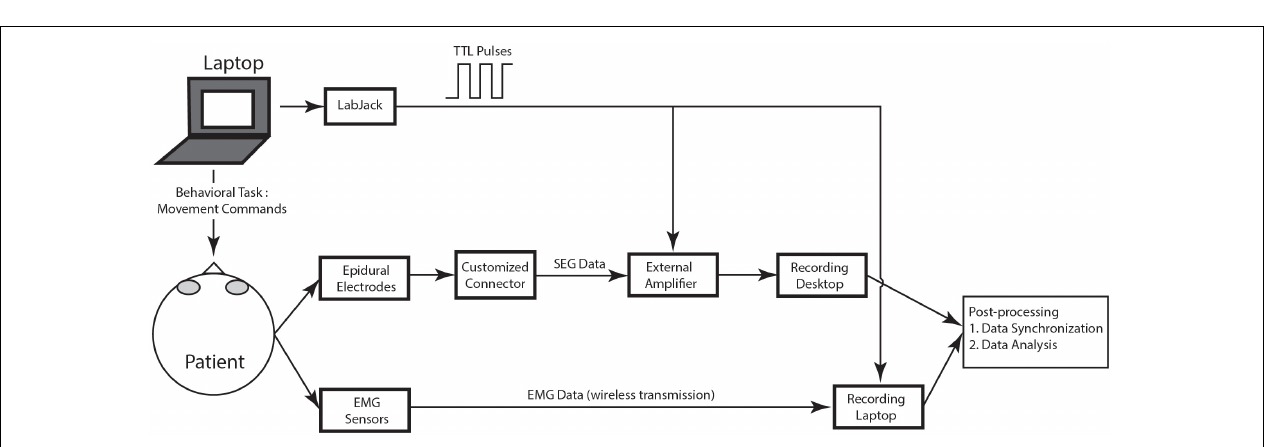
FIGURE 4 | Schematic of recording protocol. In the schematic, the various modules of the recording protocol are